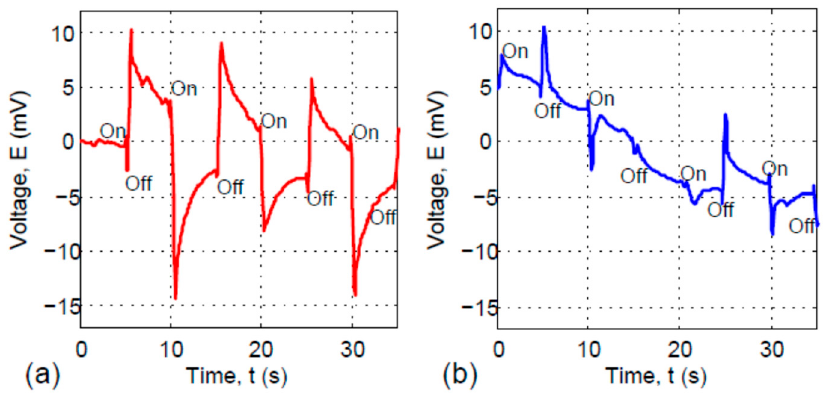
Figure 4. Open-circuit voltages of the cobalt(II) titanate particle-containing composite carbon fiber ( a ) and the titanium dioxide particle-containing composite carbon fiber ( b